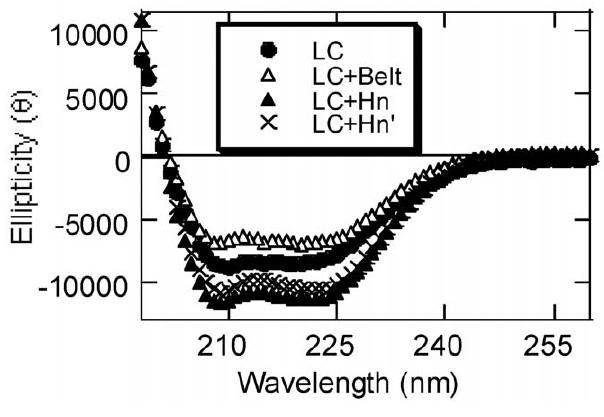
Figure 5. Tryptophan fluorescence spectra of the LC variants at 20 u C. Fluorescence emission of each protein collected at 0.20– 0.33 mg/ml in 50 mM sodium phosphate, pH 6.5, was adjusted for 1 m M protein/tryptophan. LC (closed circle), LC + Belt (open triangle), LC + Hn (closed triangle), and LC + Hn’ (crossed X).